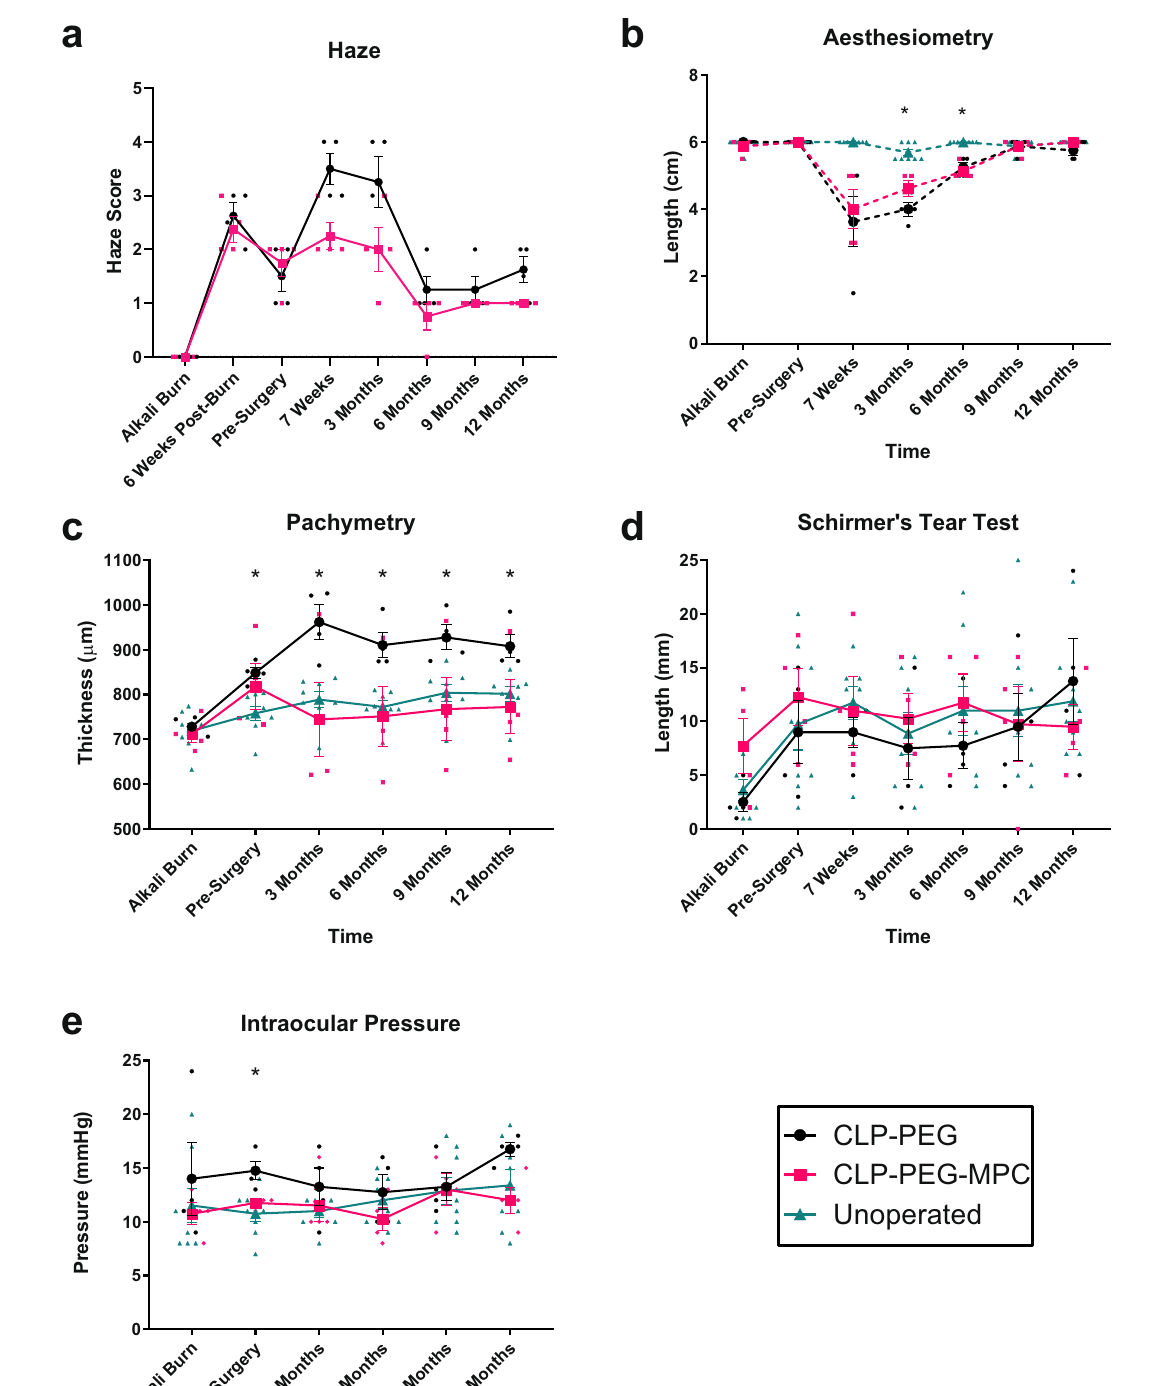
unevenly spaced stromal keratocytes with fewer cell layers (Fig. 7b, e), suggesting a still-evolving morphology. Extracellular vesicles and exosomes . Intense staining for Tsg101- positive extracellular vesicles (EVs) was seen in CLP-PEG neo- corneas (Fig. 8b) compared to unoperated controls (Fig. 8c). Colocalization of Tsg101 and the exosomal surface marker CD9, showed that many of the EVs were exosomes (Fig. 8e). The CLP- PEG-MPC implants showed a slightly higher amount of both